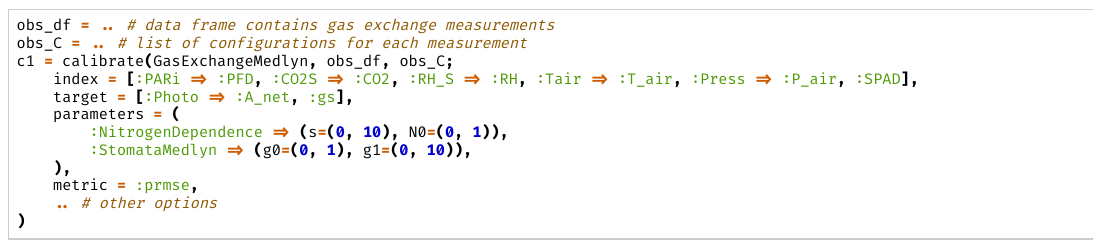
Figure A4. Script for calibrating parameters for the gas-exchange model. index option provides a mapping of variable names between a dataset and the model specification. target option indicates two variables, A n and g s , for which fitting errors are minimized. parameters option specifies a range of parameter values to be calibrated. A set of calibrated parameters are stored in a variable named c1 . Plotting model response in multiple ranges of criteria would require aggregation of results from models running multiple times with slightly different configuration. visualize() function takes